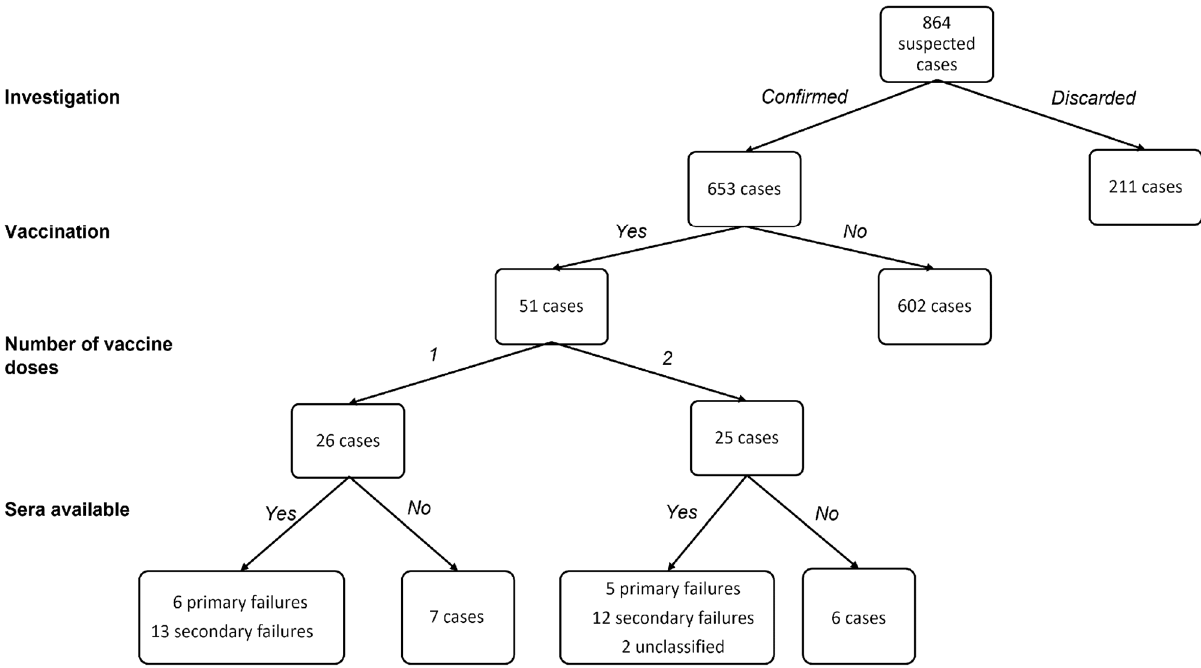
Figure 2. Patient inclusion flow-chart. Table 2. Characteristics of individuals with primary and secondary MV vaccine